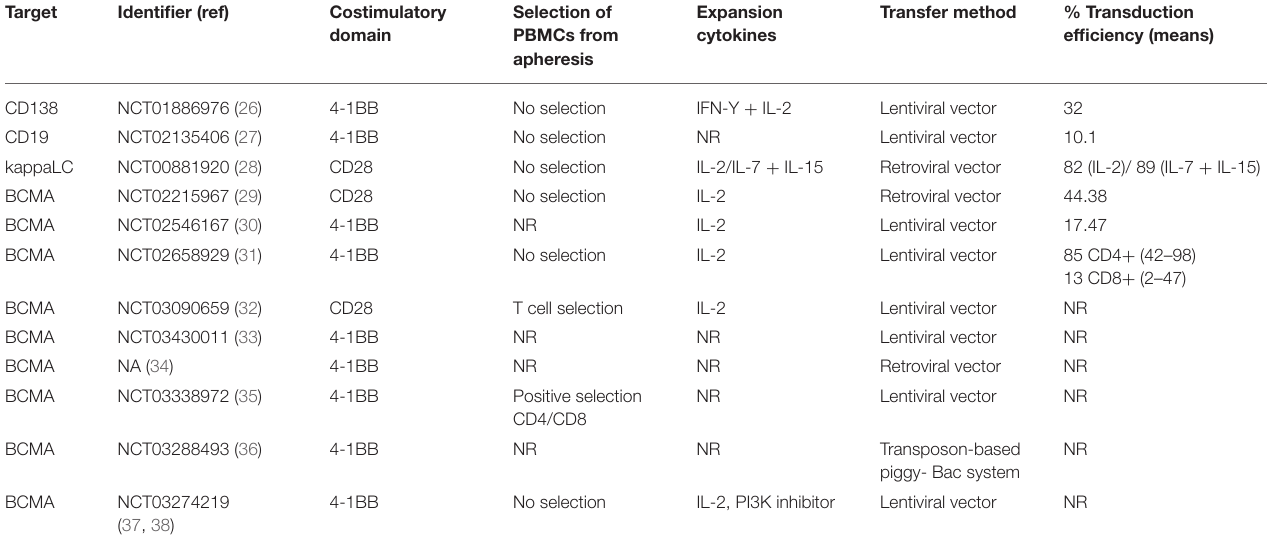
TABLE 1 | Characteristics of T-cell products generated in each clinical trial.